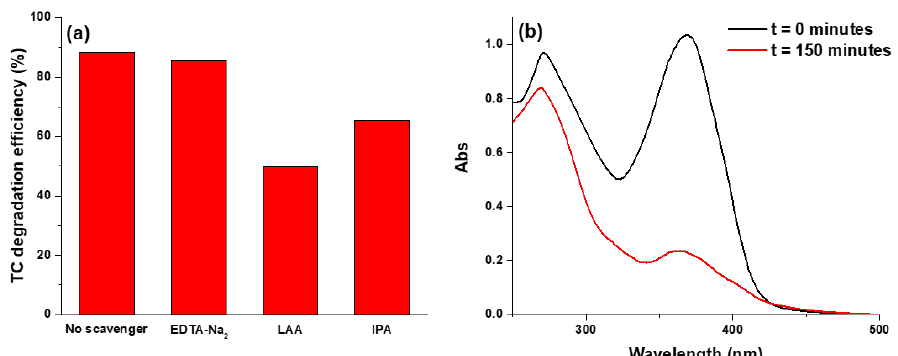
Figure 6. ( a ) Degradation efficiency of TC (%) of ZnO/γ-Fe 2 O 3 composite material in presence of ROS scavengers after 150 min of light irradiation; ( b ) UV-Vis adsorption spectra of a TC solution (30 mg/L) in presence of ZnO/γ-Fe 2 O 3 composite material (0.5 mg/mL) before and after 150 min of light irradiation.